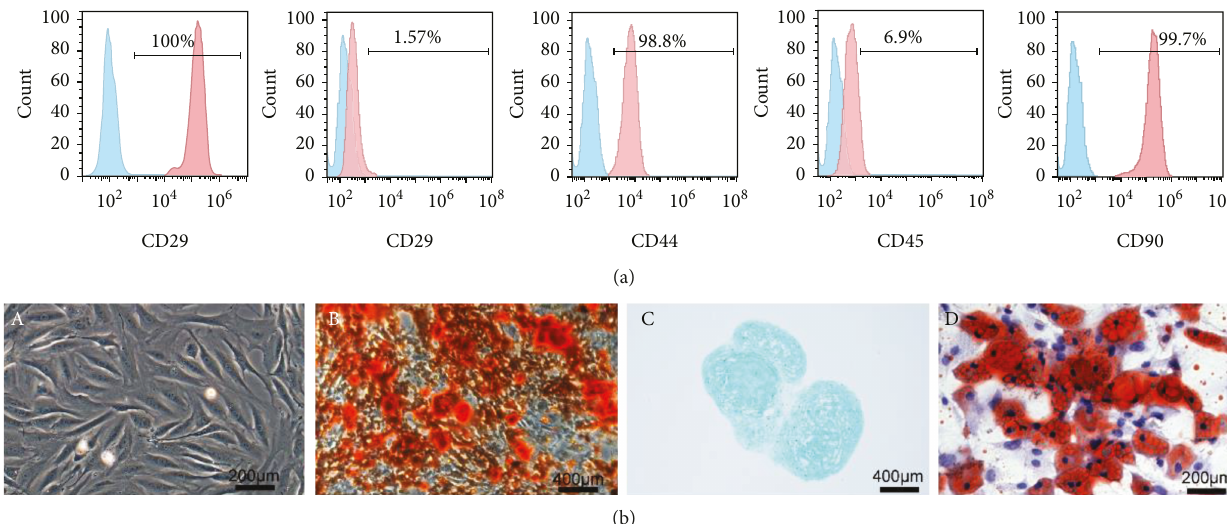
Figure 1: Phenotypic characterization of rat MSCs. (a) MSC immunophenotypic pro fi les were detected by using a fl ow cytometer. The red lines indicate the fl uorescence intensity of cells stained with the corresponding antibodies, and the green lines represent isotype-matched negative control cells. (b) Passage 3 MSCs (A) were treated with the osteogenic di ff erentiation medium for 21 days and then stained with alizarin red (B), alcian blue of the MSC pellet after chondrogenic induction for 21 days (C), and oil red O of MSCs after adipogenic induction for 12 days (D).